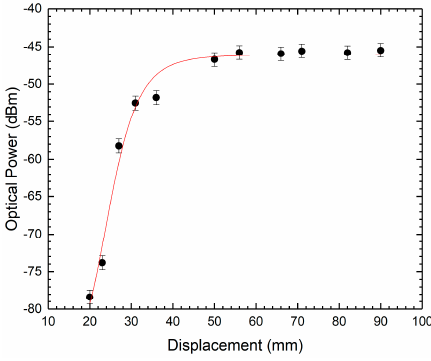
Figure 7. Output power as a function of the displacement d .